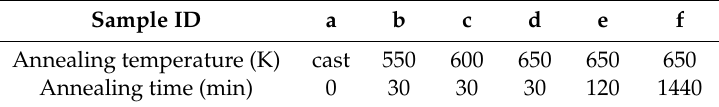
Table 1. The annealing parameters of the samples used in this